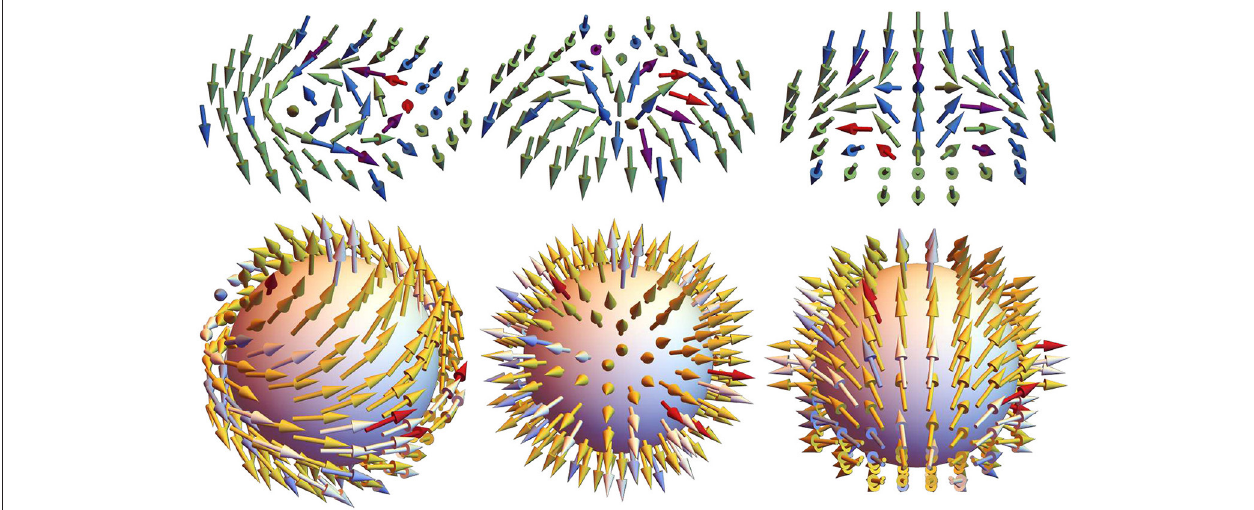
FIGURE 1 | (Top) Bloch (left) and Néel (middle) skyrmions with topological charge Q p 1. (Bottom) For Néel skyrmion (left), Bloch skyrmion (middle), and antiskyrmion (right) the moments wrap around a unit sphere upon application of stereographic =